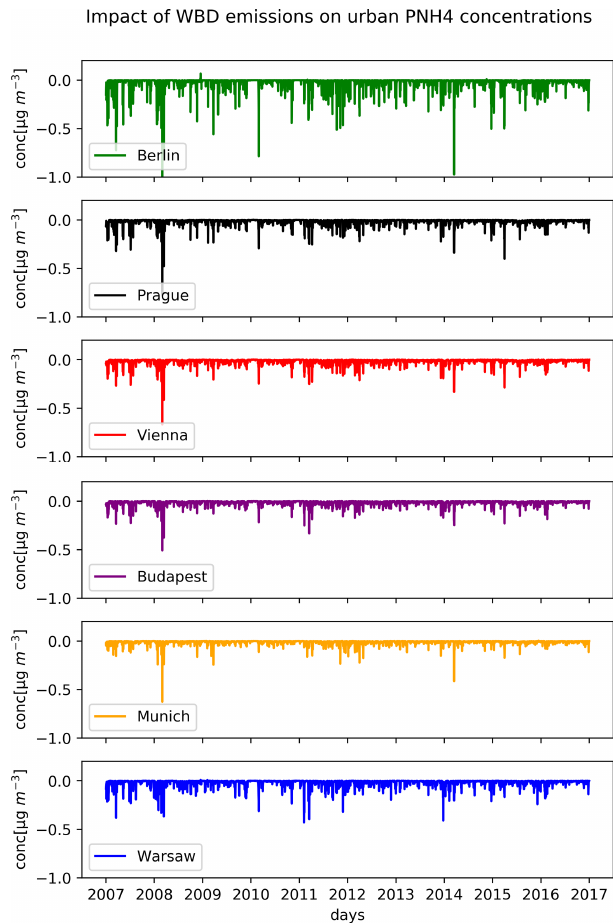
Figure 25. The long-term WBD impact on PNH 4 concentrations in ISORROPIA, averaged daily for 2007–2016. Units are micrograms per cubic